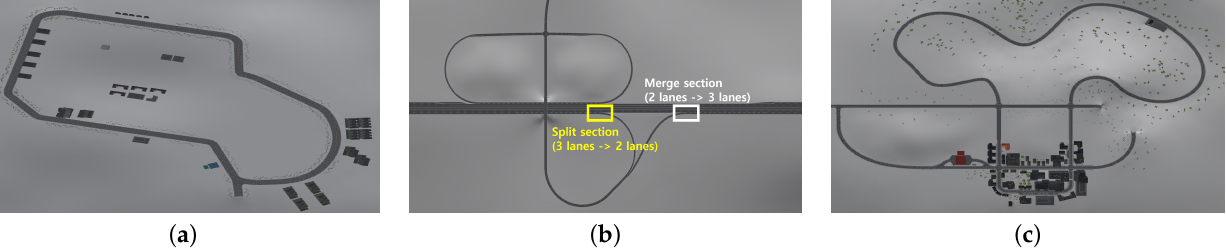
Figure 9. CarMaker simulation roads for dataset generation: ( a ) DGIST Campus environment. ( b ) Highway environment. ( c ) Urban